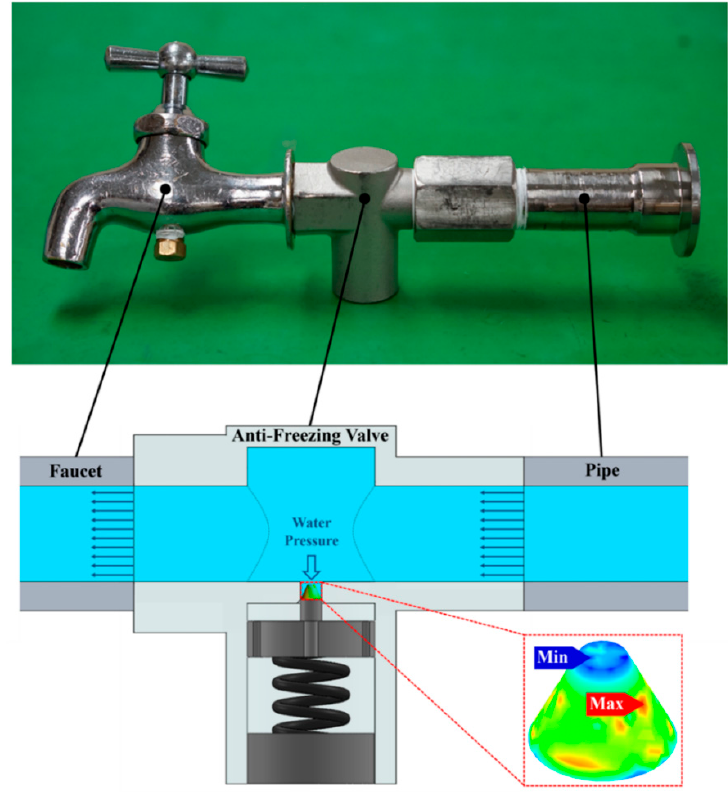
Figure 11. Application of anti-freezing systems to water pipeline.